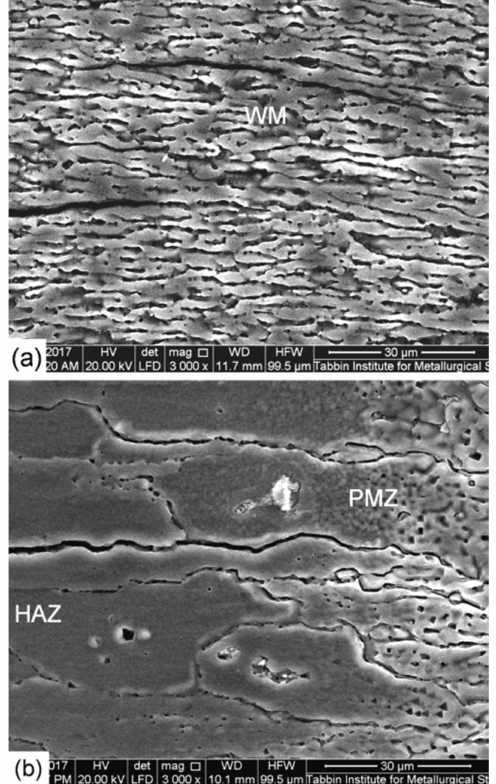
Figure 6. High-magnification SEM photographs of a cross-section ( a ) WM and ( b ) PMZ, HAZ zone of the low heat input laser-welded joint.